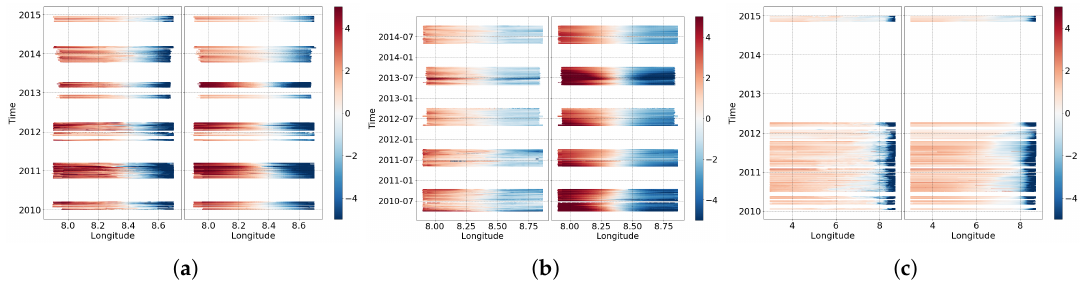
Figure 12. Density anomalies from the three ferry lines and corresponding model results. The observational data are on the left and the corresponding model results are on the right of each panel. Ferries: ( a ) Cuxhaven–Helgoland; ( b ) Büsum–Helgoland; and ( c ) Cuxhaven–Immingham.